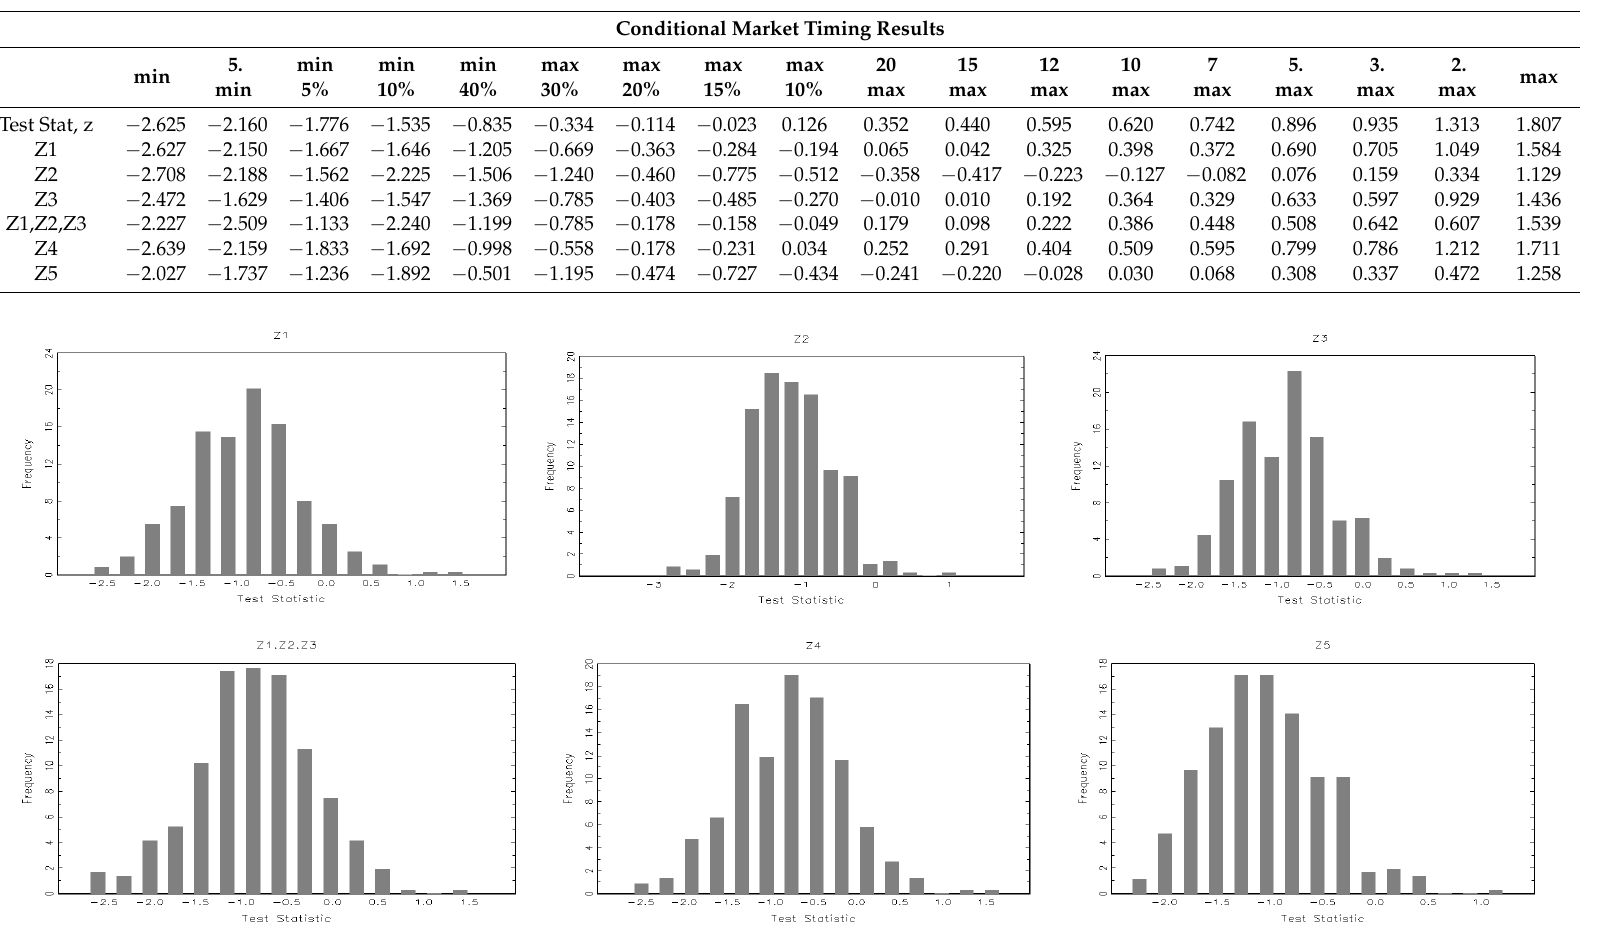
Table 4. Securities Investment Fund Market-Timing Performance—Conditional Tests.